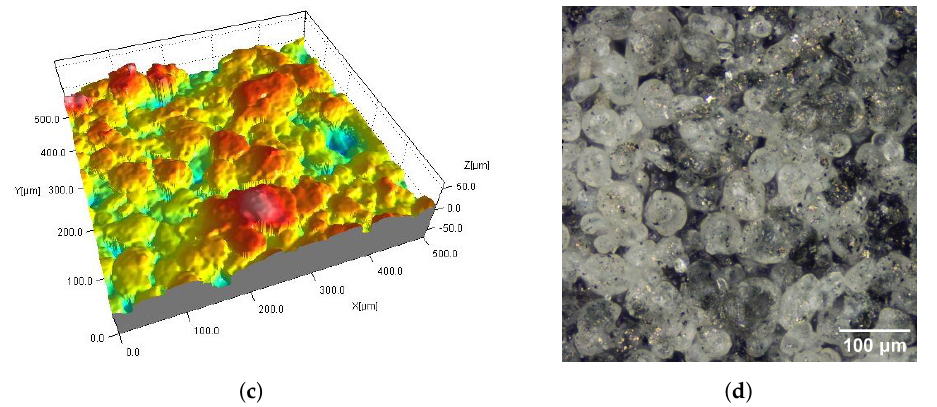
Figure 7. Surfaces of MJF samples with antibacterial coatings AC_Ag ( a , b ) and AC_Glass ( c , d ): fragments 0.5 mm × 0.5 mm of 3D maps ( a , c ) and corresponding 2D views ( b , d ).